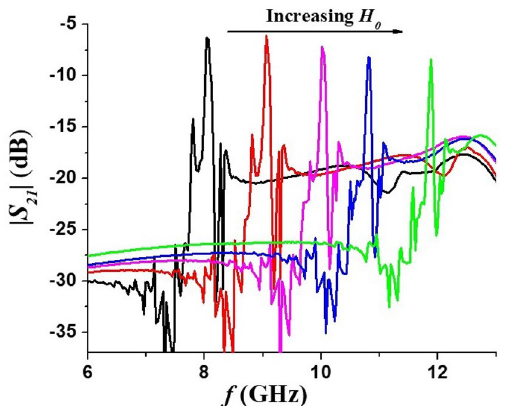
Figure 2. Simulation of the proposed band-pass filter transmission properties in the X-band.